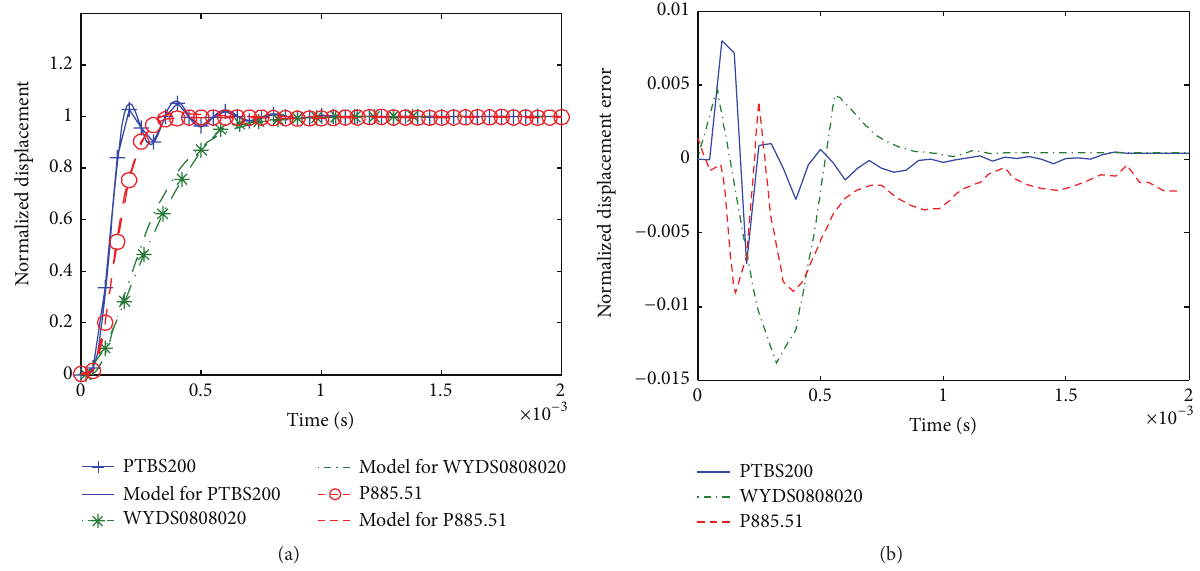
Figure 9: Normalized unit step responses of the three PSAs measured by the LDV and predicted by the modified comprehensive model: (a) the normalized unit step responses and (b) the modeling errors.